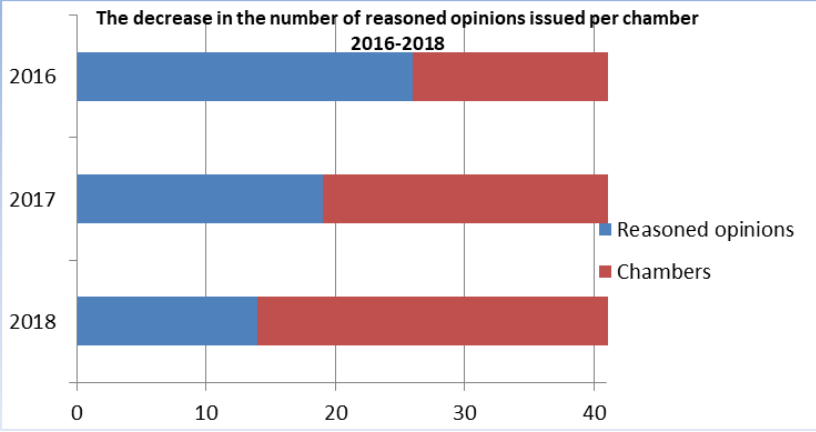
Figure 3. The decrease in the number of reasoned opinions issued per chamber (2016–2018). Source: own elaboration using information available in the annual report for 2018.